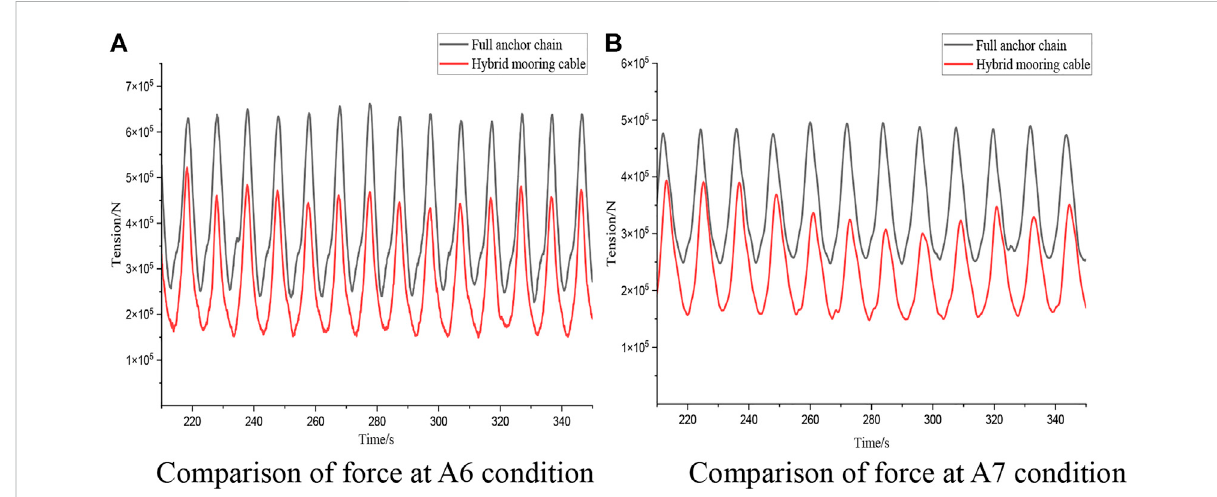
FIGURE 14 Comparison of force of the mooring system. (A) . Comparison of force at A6 condition (B) . Comparison of force at A7 condition.